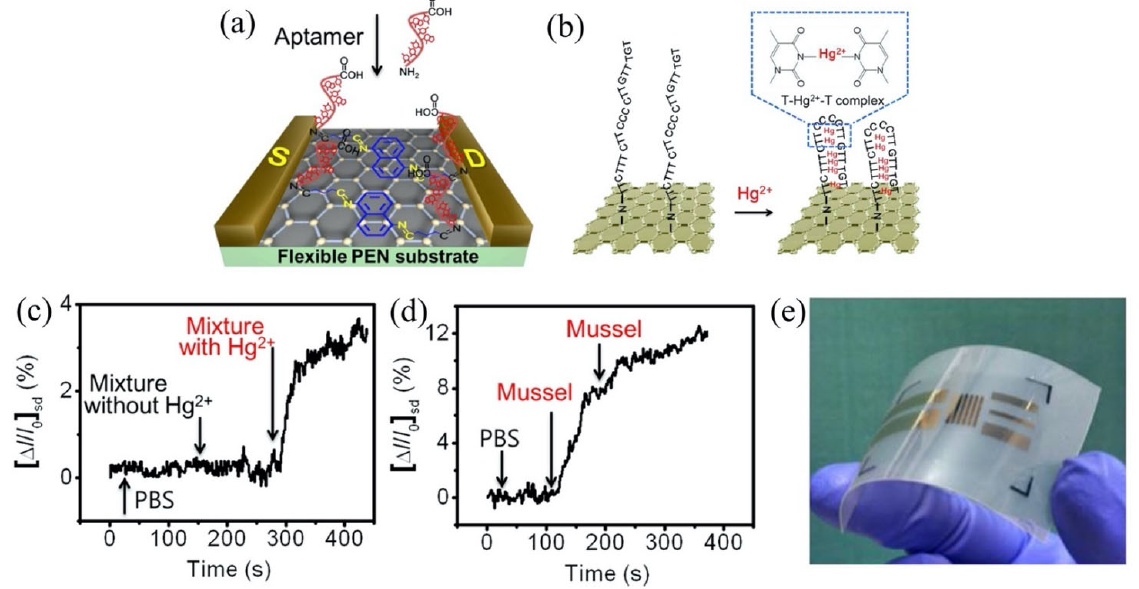
Figure 8. Graphene FET sensor for detection Hg 2+ in mussels. ( a ) Aptamer (30 ‐ amine ‐ TTC TTT CTT CCC CTT GTT TGT ‐ C10 carboxylic acid ‐ 50) was functionalized on graphene FET channel surface. ( b ) Interaction of Hg 2+ with thymine base pair. ( c ) Real ‐ time FET sensor response in a solution containing Hg 2+ ions. ( d ) Real ‐ time FET sensor response in a real sample mussels’ solution. ( e ) Flexible, transparent and lightweight graphene FET sensor device. Reprinted (adapted) with permission from [149]. Copyright 2013 American Chemical Society.